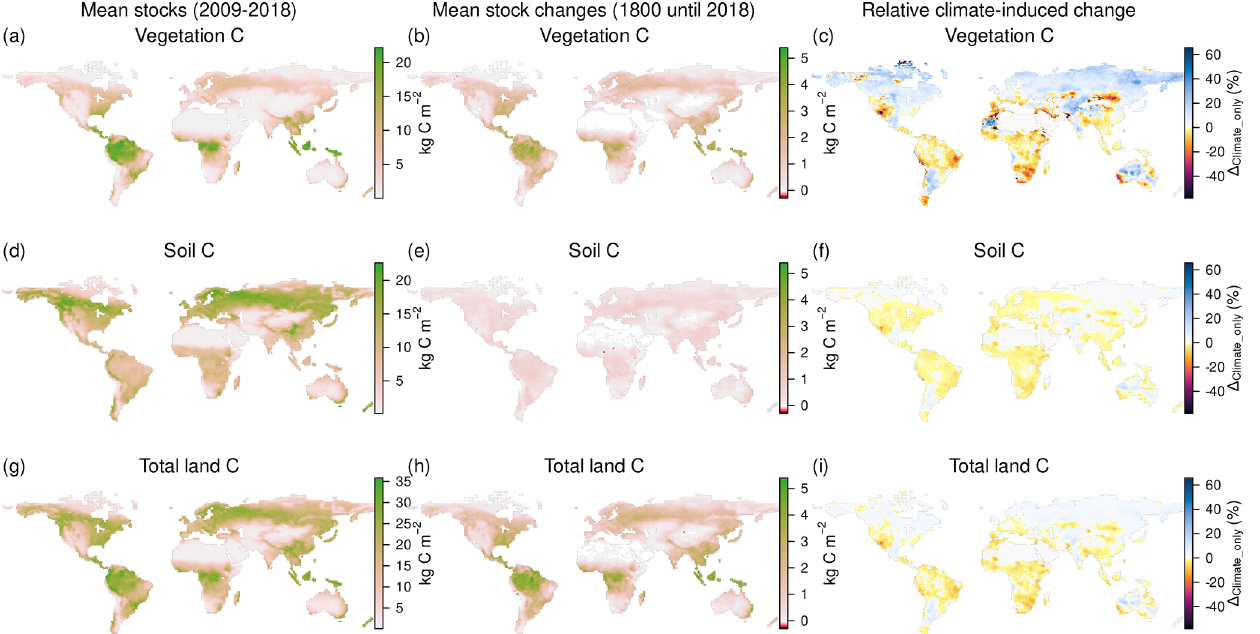
Figure A3. Ensemble mean C stocks from 2009–2018 in the S2 simulation ( a, d, g ; observed environmental conditions and pre-industrial land use and land cover), mean C stock changes between 1800 and 2018 (b, e, h) , and their climate-induced percentage changes ( c, f, i , 100 × (S2 − S1) / S2) of vegetation ( a–c ; for relative change, values < − 60% were set to − 60%), soils (d–f) , and their totals (g–i) . The relative climate-induced changes indicate additional (blueish) and reduced (reddish) stocks due to historic climate change (grid points < 1kgCm − 2 total C stock